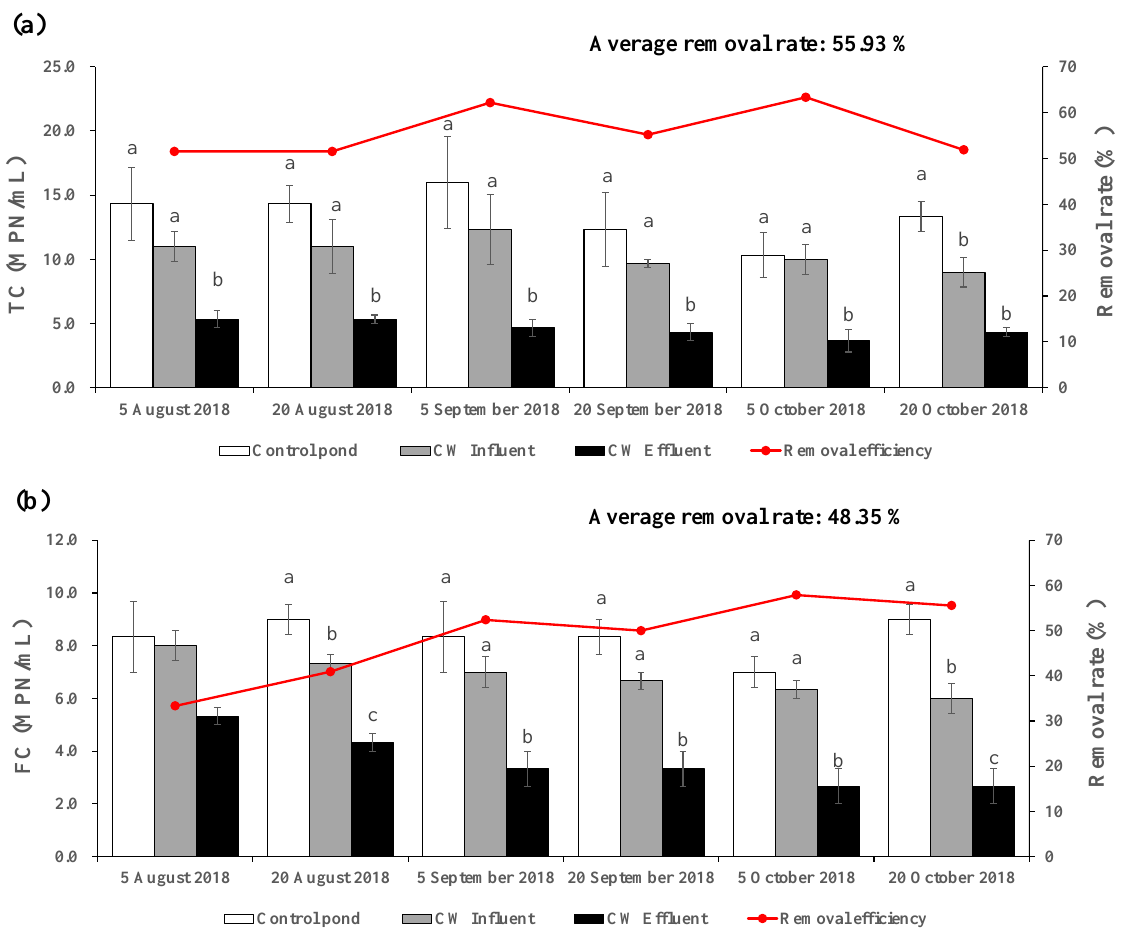
Figure 7. Concentrations of TC ( a ) and FC ( b ) in water samples collected from the control pond and the inlet and outlet of CW, and the removal efficiency during the monitoring period. The value is expressed as mean ± SE ( n = 6), and different small letters in bar graphs indicate significant differences ( p < 0.05) among the control pond, CW influent and CW effluent.